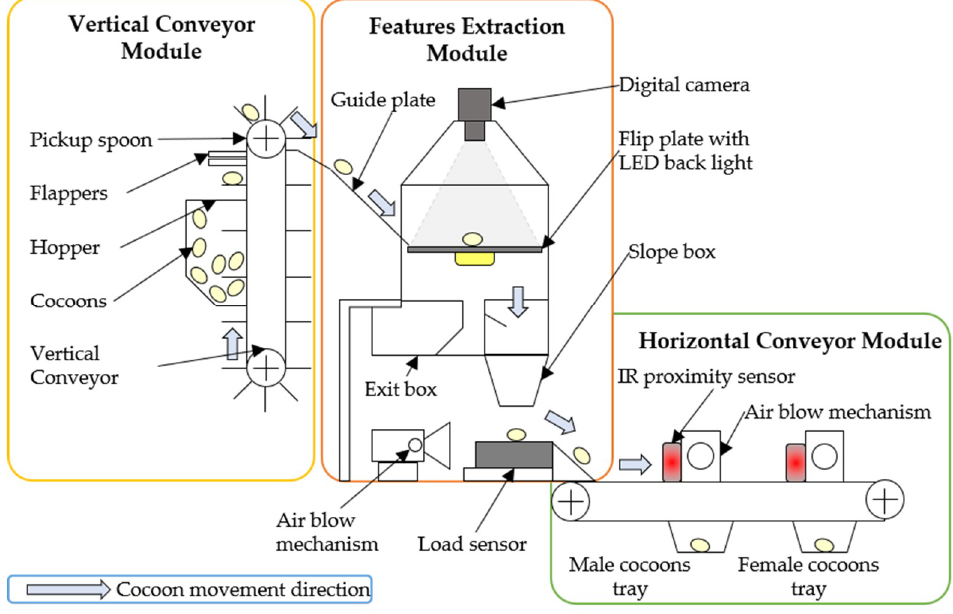
Figure 4. Schematic of silkworm cocoons separating machine.